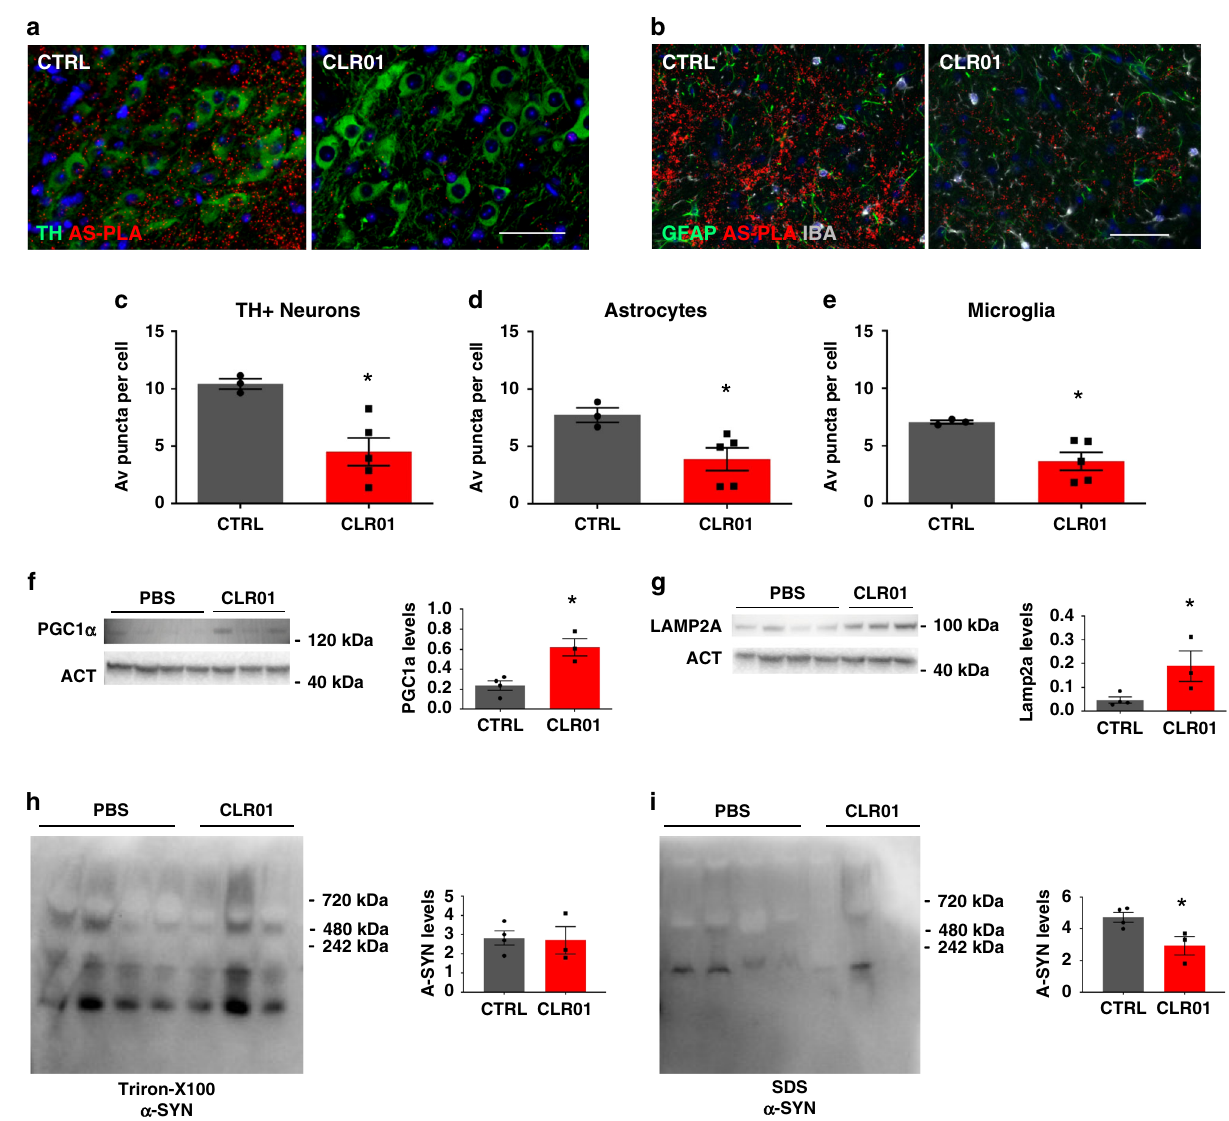
Fig. 5 CLR01 reduces α -syn aggregation in vivo at 18 months of age. a – e Representative images and quanti fi cation of AS-PLA puncta per TH + , GFAP + , and Iba1 + cells after osmotic mini-pump implantation of 40 µ g/kg/days CLR01 or PBS, analyzed using a two-tailed t -test, n = 3/4 independent animals. Scale bars = 50 µ m. c p = 0.0117, d p = 0.0319, e p = 0.0179. f , g Western blottings of PGC1 α and Lamp2a, analyzed using a one-tailed Mann – Whitney U -test, n = 3 – 4 independent animals. f p = 0.0286, g p = 0.0286. h , i Native western blottings of Triton X-100 and SDS-soluble α -syn, analyzed using a one-tailed Mann – Whitney U -test, n = 3 – 4 independent animals. i p = 0.0286. * p < 0.05. AV average, CLR CLR01. For all appropriate panels, data are presented as mean values ±